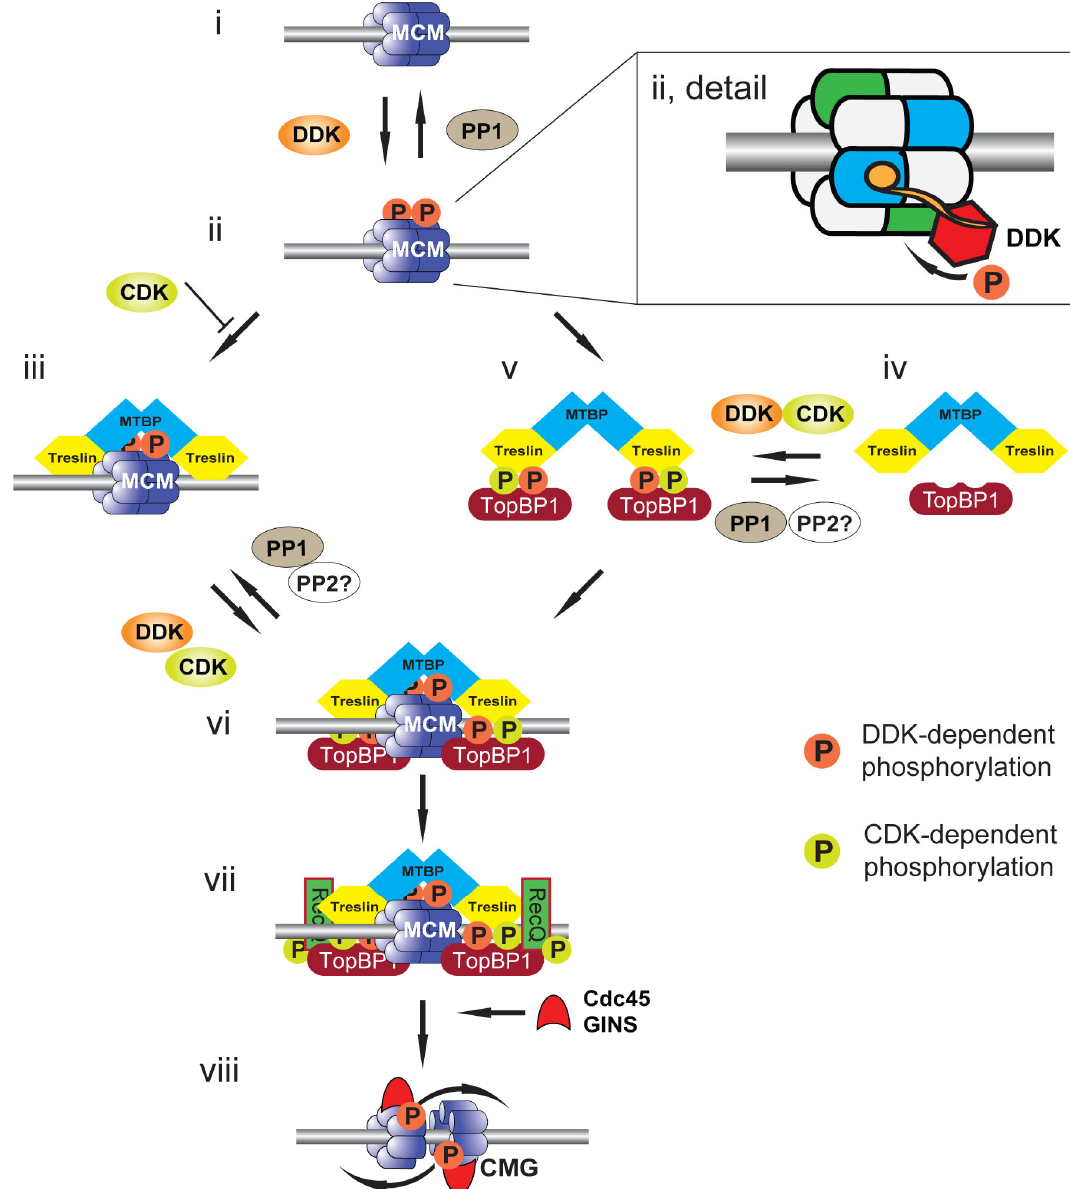
Figure 2. Model for CMG formation and activation. Cartoon illustrating events at a replication origin leading to replication initiation. ( i ) Replication origin DNA (grey bar) licensed by DNA ‐ bound MCM2 ‐ 7 double hexamer (blue). ( ii ) DNA ‐ bound MCM2 ‐ 7 is phosphorylated by DDK (or